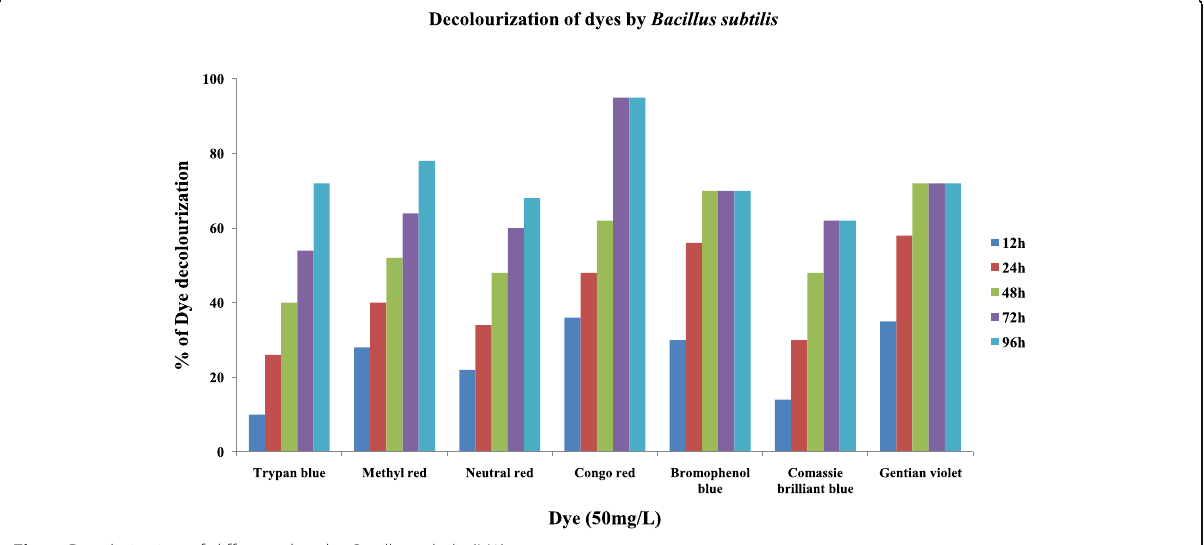
Fig. 4 Decolorization of different dyes by Bacillus subtilis (M3)